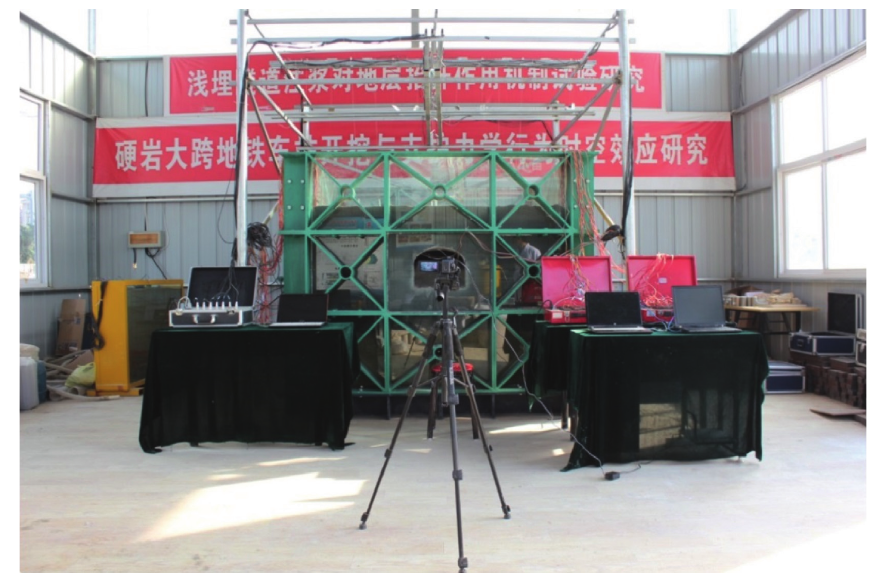
Figure 11: Test scene for the model excavation.